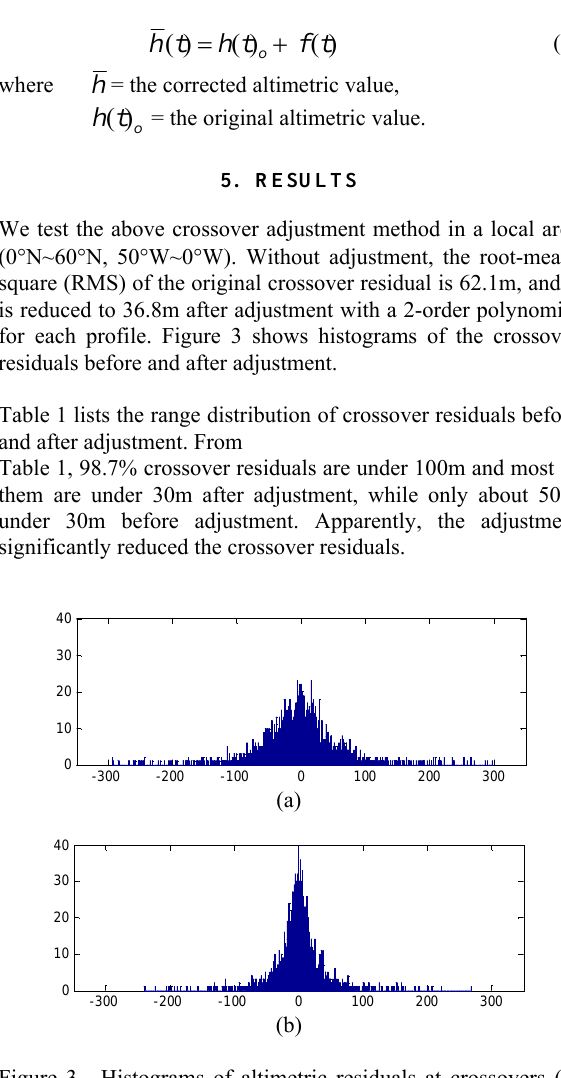
Figure 3. Histograms of altimetric residuals at crossovers (a) before and (b) after adjustment